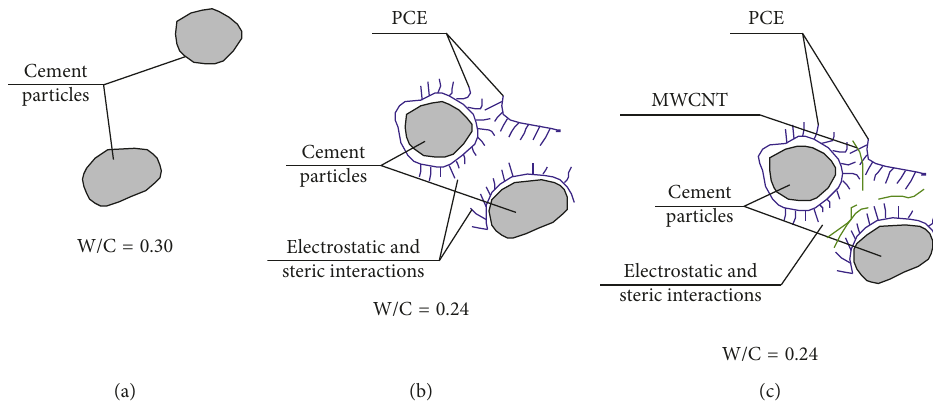
Figure 16: Mechanism of interaction of cement particles. (a) Without PCE. (b) With PCE. (c) With PCE and MWCNT dispersion.